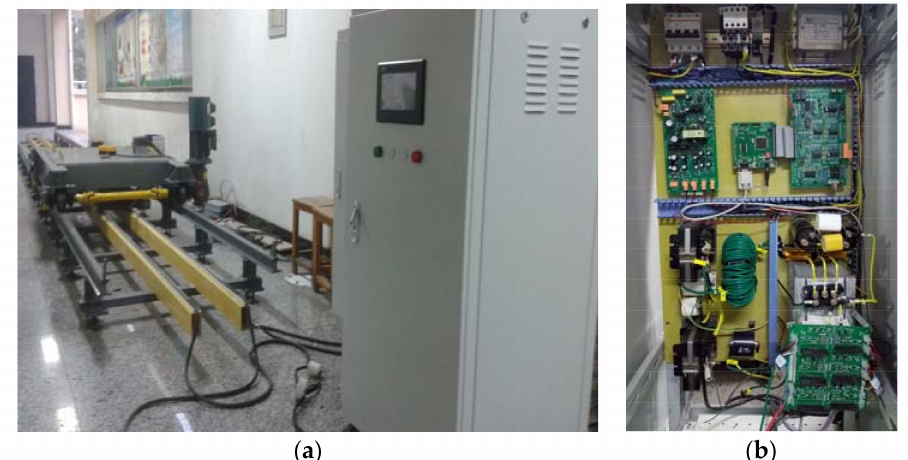
Figure 16. Experimental platform of IPT system: ( a ) experimental panorama of the platform; ( b ) the converter of the primary side.